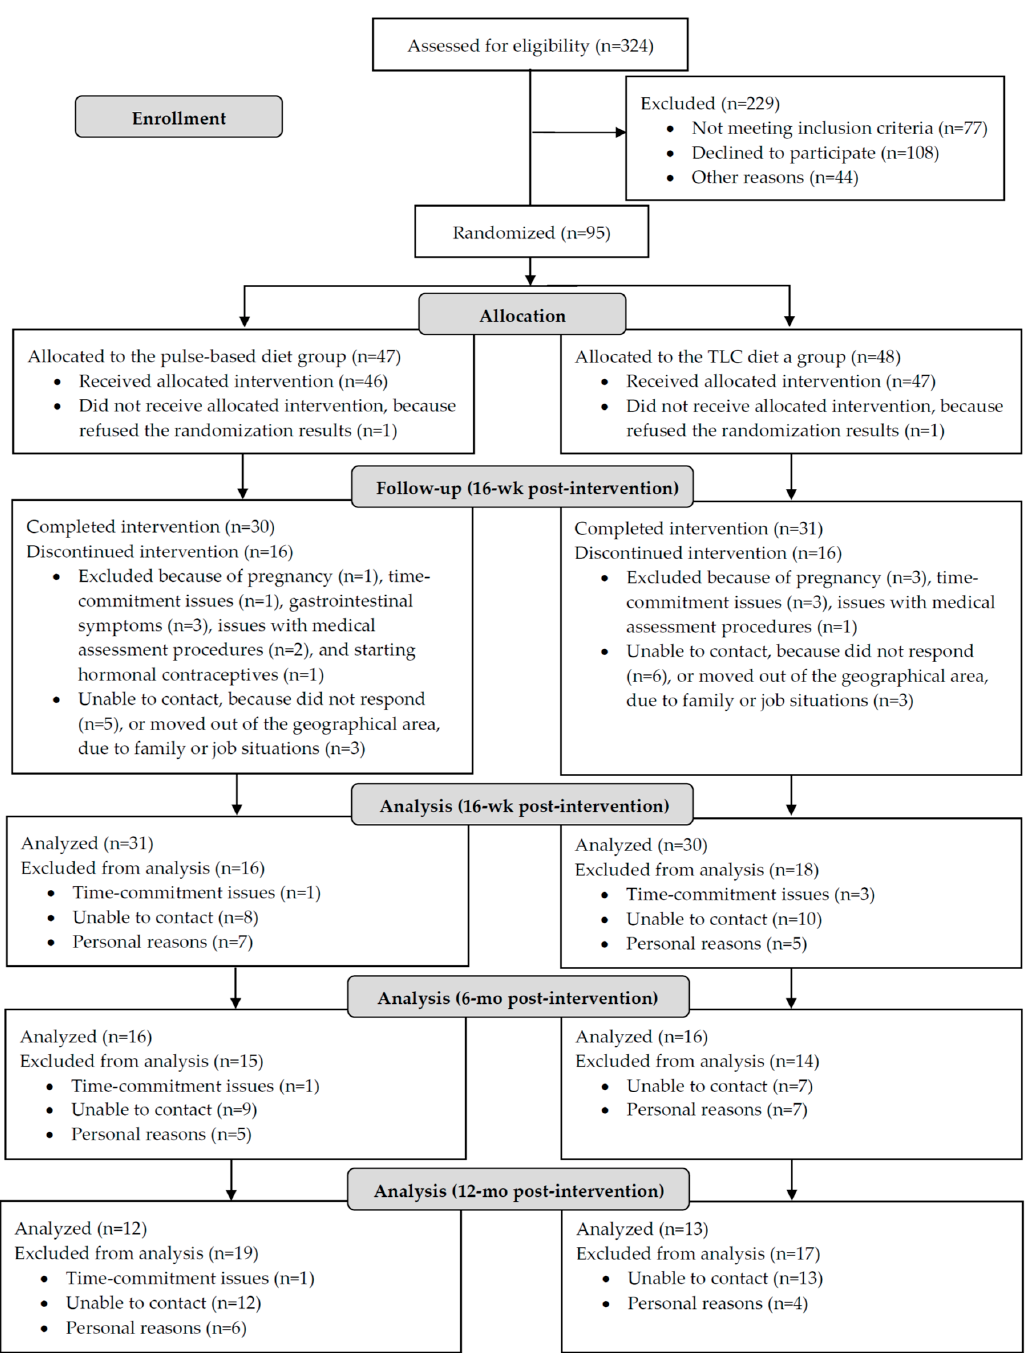
Figure 1. CONSORT flow diagram of the randomized controlled trial. In the “follow-up (16-week post-intervention)” section—“completed the intervention”—represented women who completed the 16-week lifestyle intervention;—“discontinued the intervention”—represented women who dropped out of the study before completing the 16-week lifestyle intervention. In the “analysis (16-week post-intervention)” section, the number of subjects that were analyzed in the pulse-based and TLC diet groups included women who completed the 16-week lifestyle intervention and women who dropped out of the study before completing the 16-week intervention period, but their last observation data which were collected at nine-weeks post-intervention were carried forward to 16-week time point according to the intention-to-treat principle.